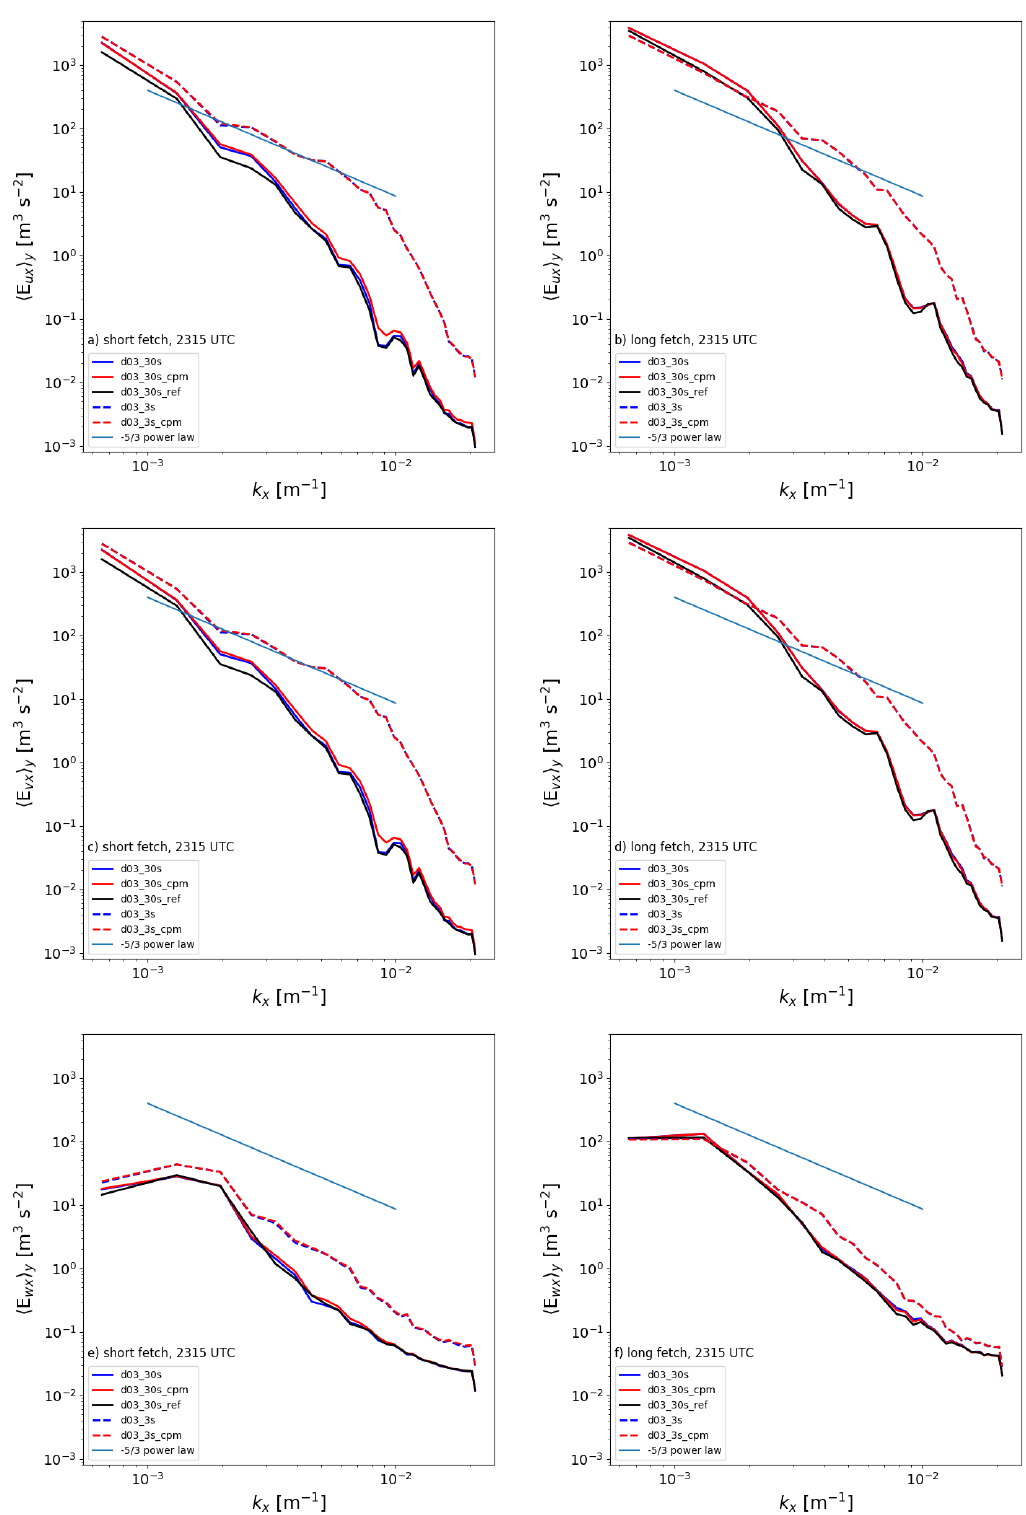
Figure 18. As in Figure 12 but for the nominal time, 2315 UTC, roughly concurrent with the 2313 radiosonde release on 20 May